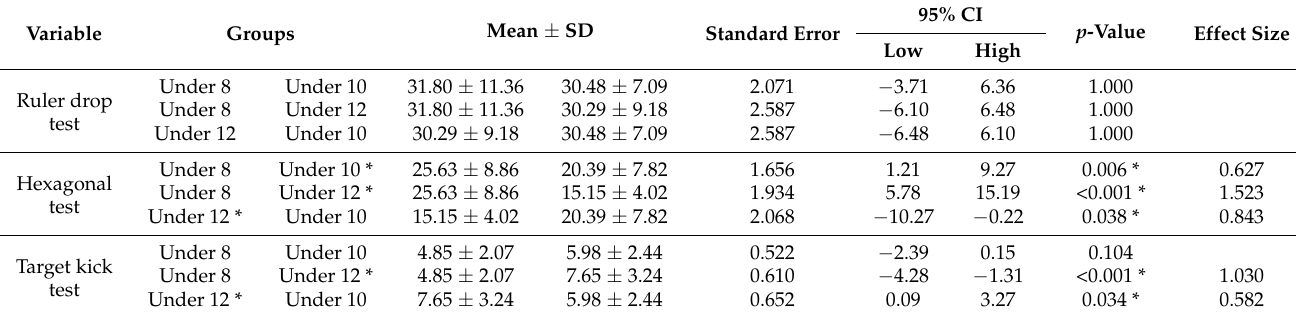
Table 2. Age differences in the motor coordination tests (n = 115).